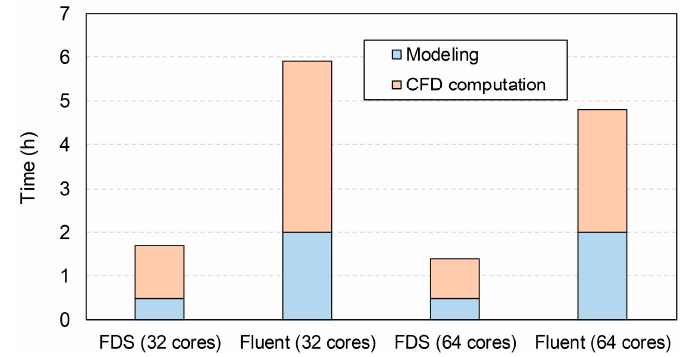
Figure 9. Modeling and computation efficiencies of the FDS and Fluent models.